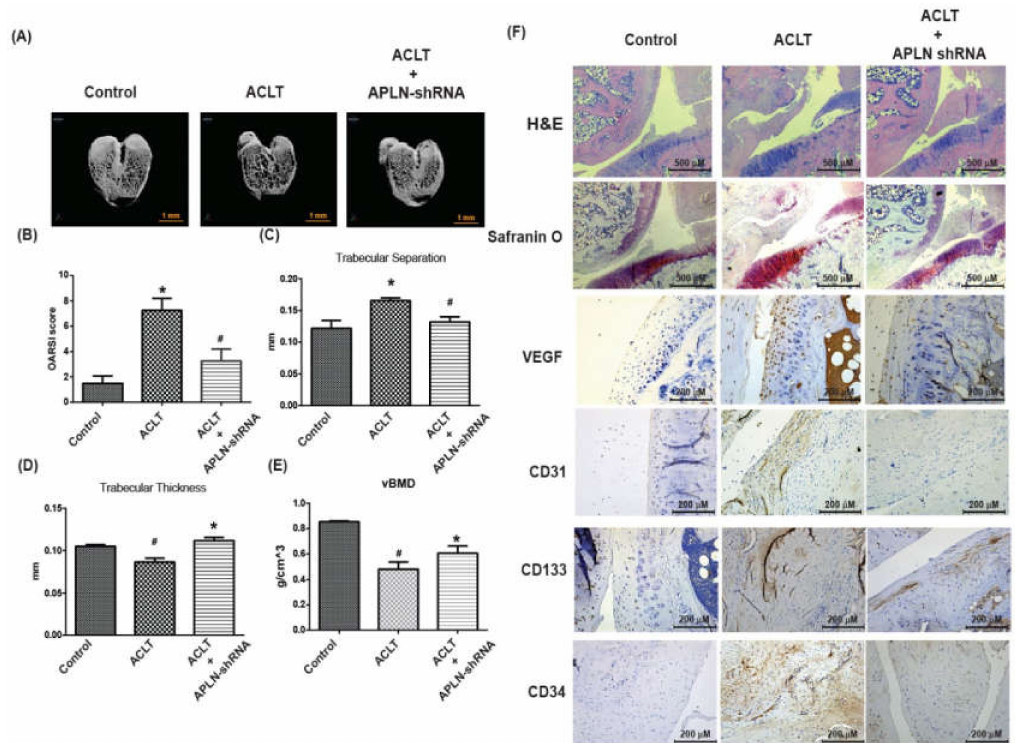
Figure 7. shAPLN ameliorates histologic severity of OA. ( A ) Micro-CT images of the control knee, anterior cruciate transection (ACLT) knee, and shAPLN-transfected ACLT knee ( n = 8). ( B–E ) OARSI scores ( B ), micro-CT parameters, including trabecular separation ( C ), trabecular thickness ( D ), and volumetric bone mineral density ( E ), of the control knee, ACLT knee, and shAPLN-transfected ACLT knee. ( F ) Specimens from the control knee, ACLT knee, and shAPLN-transfected ACLT knee were immunostained with Safranin-O, VEGF, CD31, CD133, and CD34. * p < 0.05 compared with control; # p < 0.05 compared with the APLN-treated group.